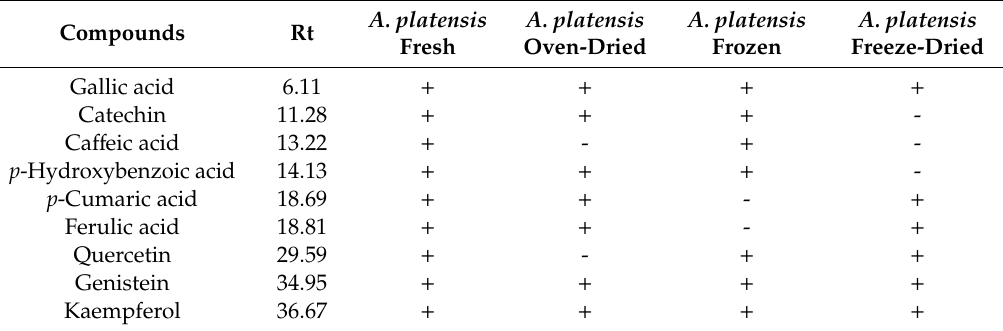
Table 3. The phenolic compounds in A. platensis